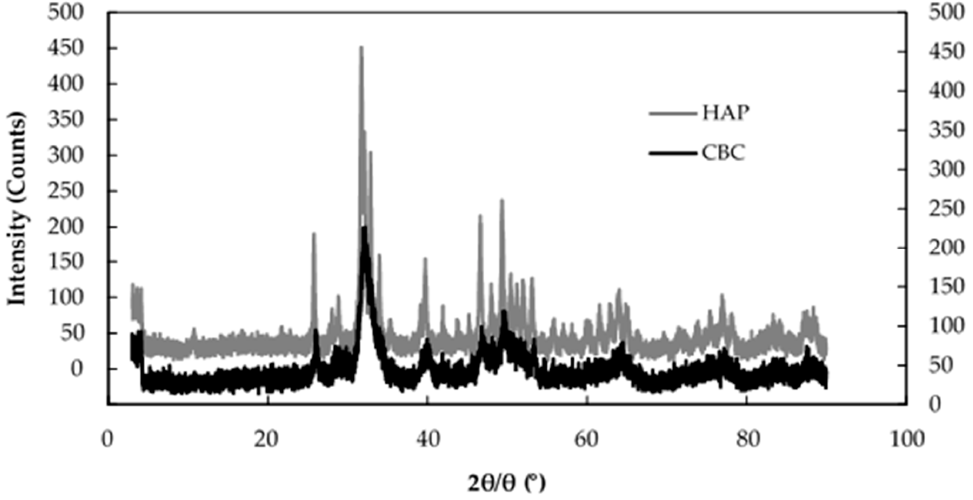
Figure 8. XRD patterns of HAP and CBC. Hydroxyapatite (HAP) (left Y axis), CBC (right Y axis). The number of moles of OH − in CBC before the fluoride adsorption was calculated based on the molar ratio of Ca 2+ :OH − (10:2) before the fluoride adsorption, assuming that the major component of CBC is hydroxyapatite. The number of moles of OH − in CBC after the fluoride adsorption was calculated based on the molar ratio of Ca 2+ :OH − (10:2) and by reducing the F − moles.